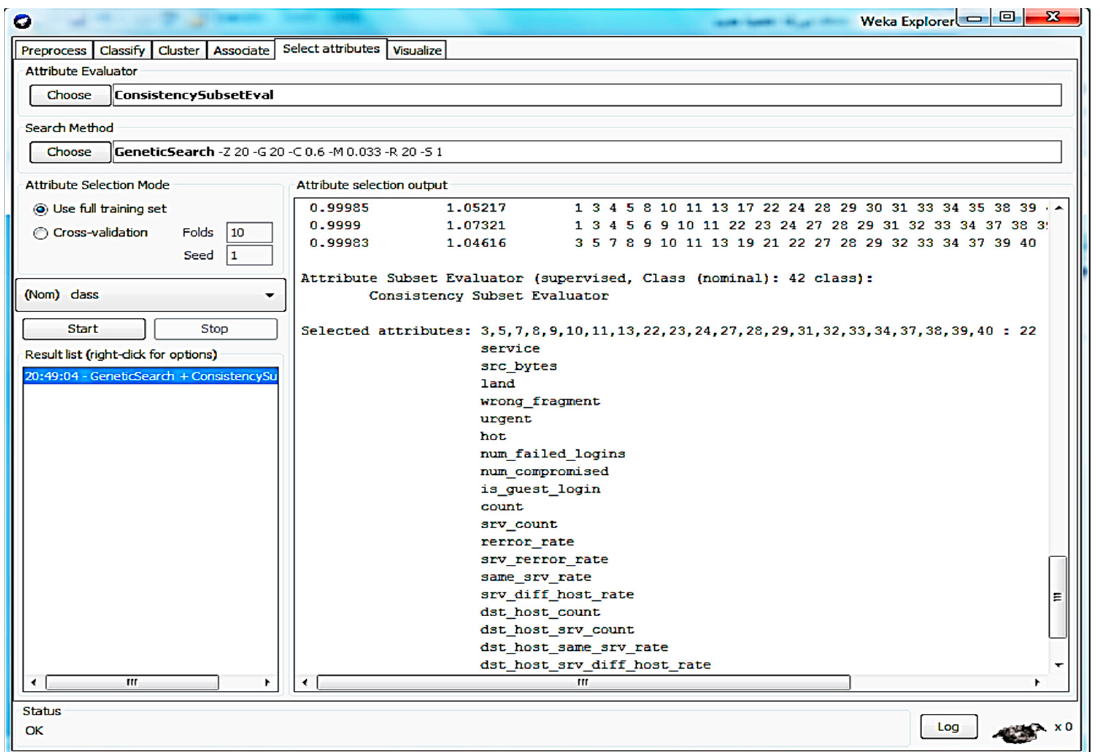
Figure 5. Feature selection consistency-subset level and genetic search algorithms.